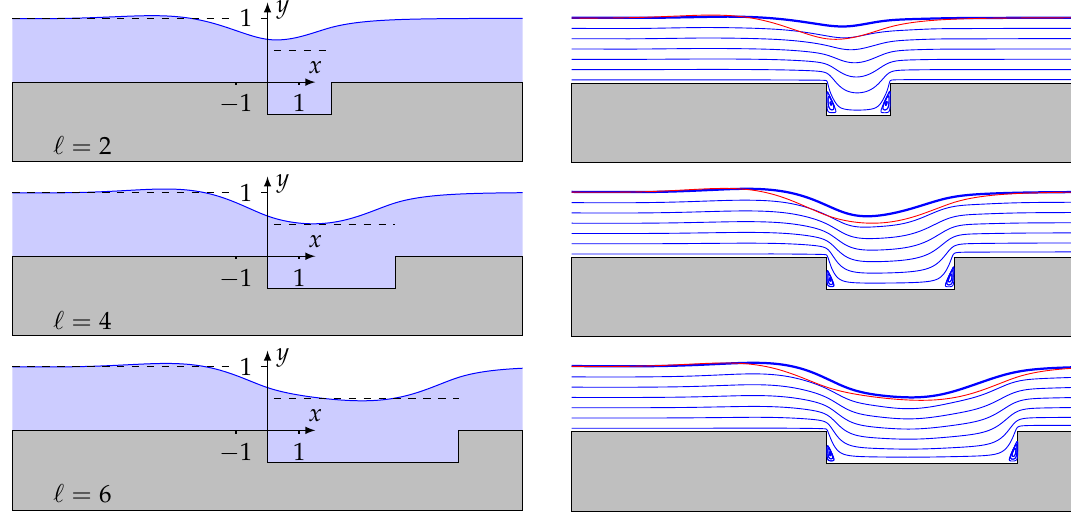
Figure 5. Predicted free surface disturbance for film flow over a trench topography ( α = 80°, a = 1/2 and Ca = 0.3 for different trench widths (cid:96) : 2 (top); 4 (middle); 6 (bottom)), obtained analytically (left column) and numerically (right column); in the latter the blue free surface streamline represents the steady-state FE solution of the first integral equations with the red curve indicating the corresponding free surface shape obtained from the linear theory. The flow is from left to right with the dashed lines indicating the equivalent corresponding asymptotic film thickness, H 0 , upstream of and in the middle of the trench.